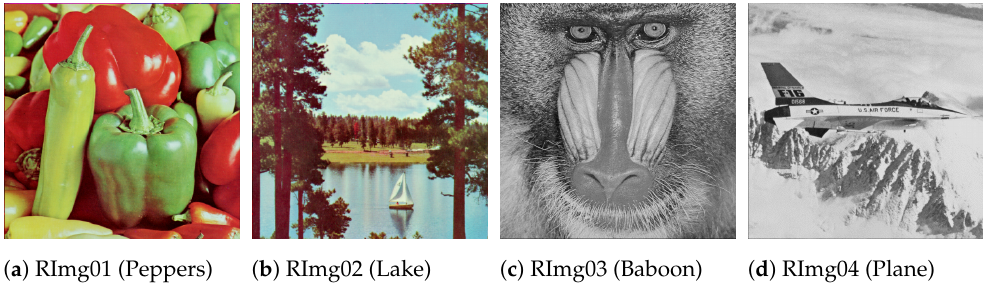
Figure 4. Reference images ( a – d ) each of size 512 × 512 used to validate the proposed